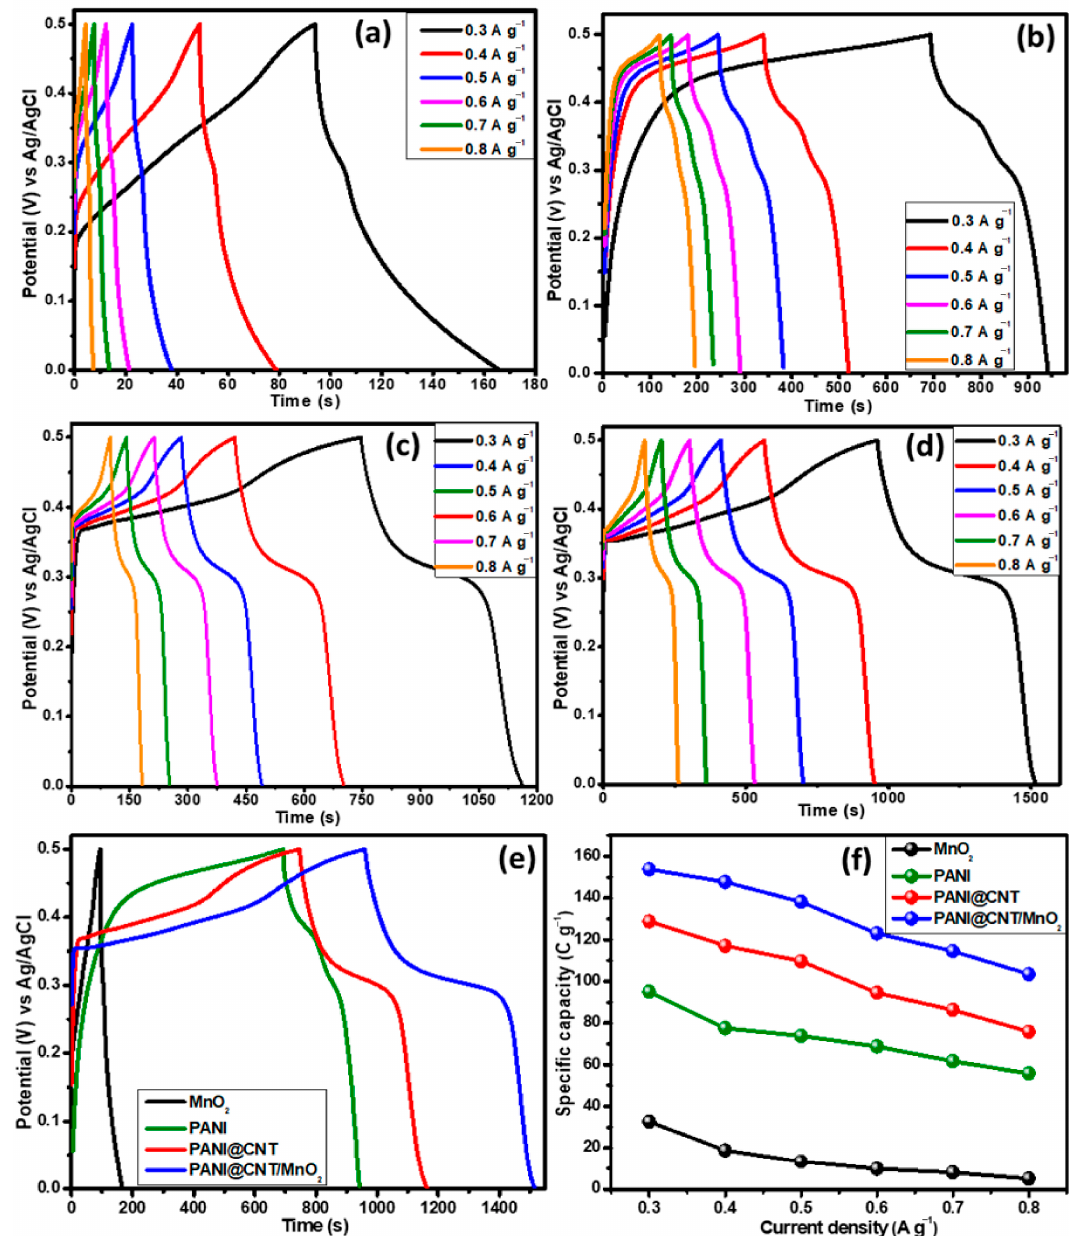
Figure 6. Galvanostatic-charge–discharge (GCD) curves at various current densities, ( a ) MnO 2 , ( b ) fibrous PANI, ( c ) PANI@CNT, ( d ) PANI@CNT/MnO 2 , ( e ) comparison curves for all four variants at a current density of 0.3 A g − 1 , and ( f ) current density vs. specific capacity plot of all four variants.